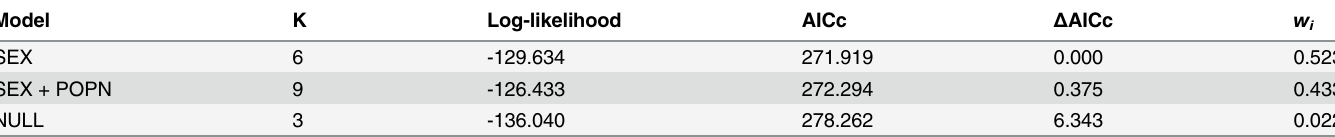
Table 4. Performance statistics of three top models of demographic factors relating to ultimate cause of mortality for 136 fishers ( Pekania pen- nanti ) within the two isolated populations, northern California and southern Sierra Nevada. The two factors in the final model were SEX (sex of the fisher) and POPN (population of